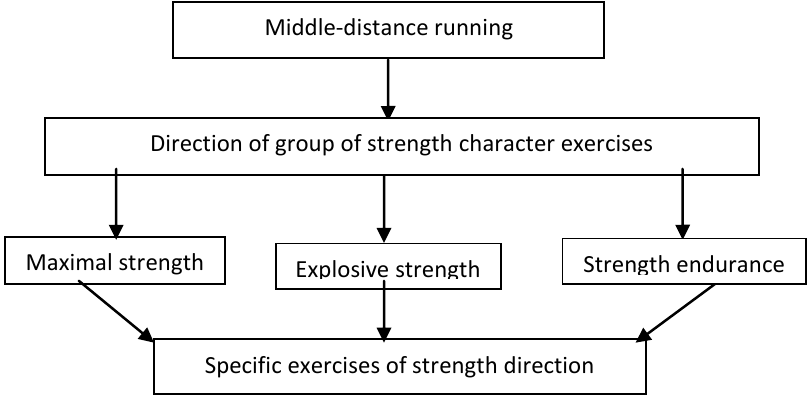
Fig. 2. Algorithm of strength preparation of middle-distance